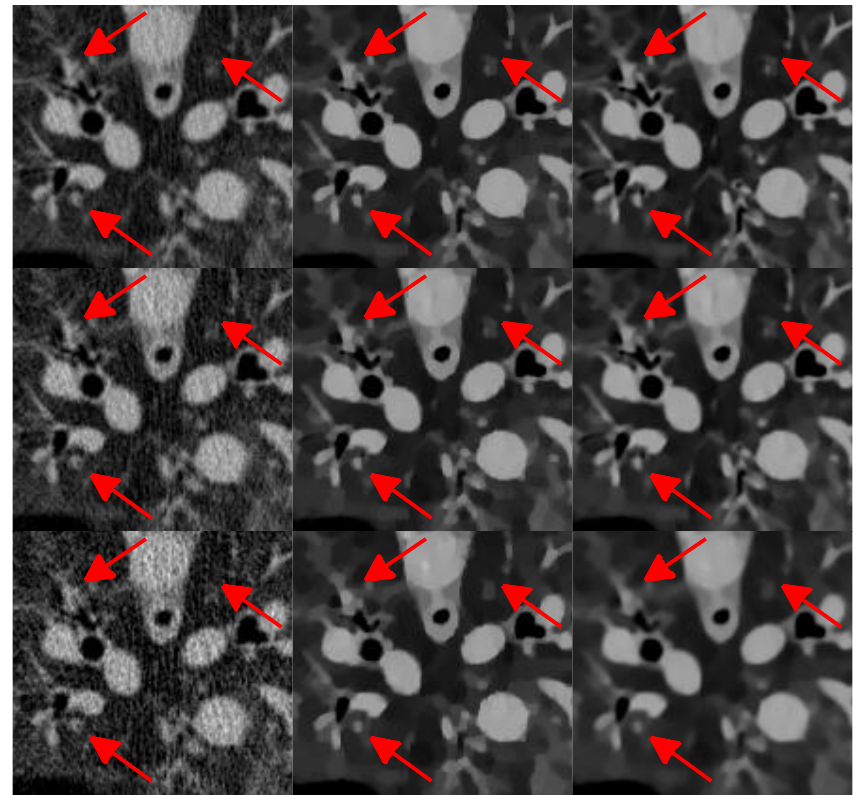
Figure 11. Zoom in view ofregion of interest(ROI) in Figure 10.